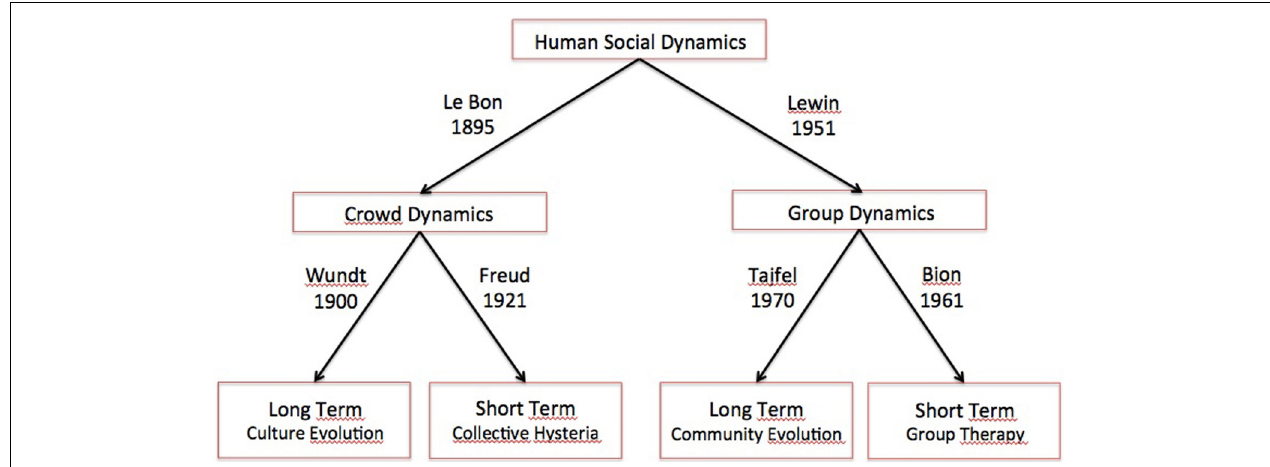
FIGURE 1 | A classification of the human social dynamics. A possible and very coarse grained picture describing the classification of human collective dynamics, provided by the classical psychological